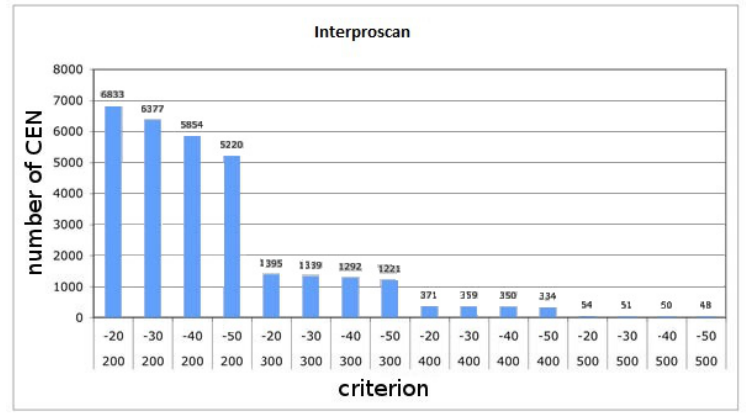
Figure 5: Distribution of transcripts according to threshold variables associated to Interproscan